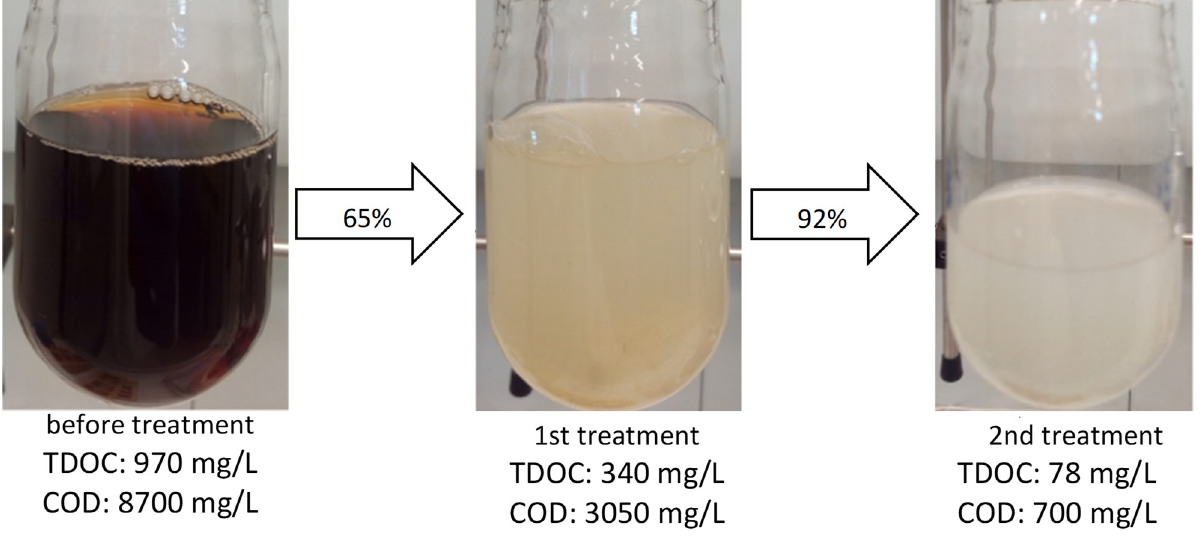
Figure 6. TDOC removal efficiency after 1st and 2nd treatments (reaction condition: 70 °C, pH 5, 200 mg/L of catalyst, H 2 O 2 30 mL/L and reaction time 150 min).